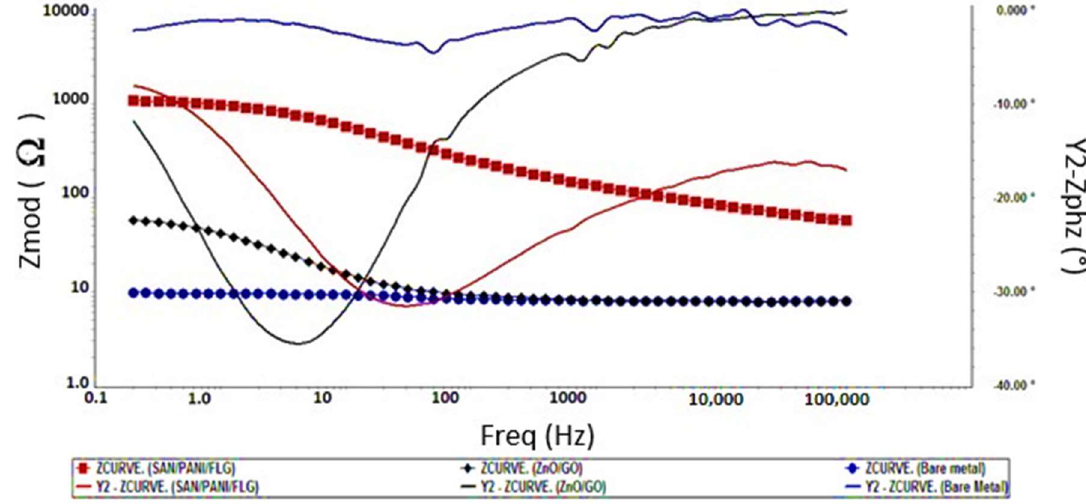
Figure 7. Comparison of Bode Plots (crude oil produced water).